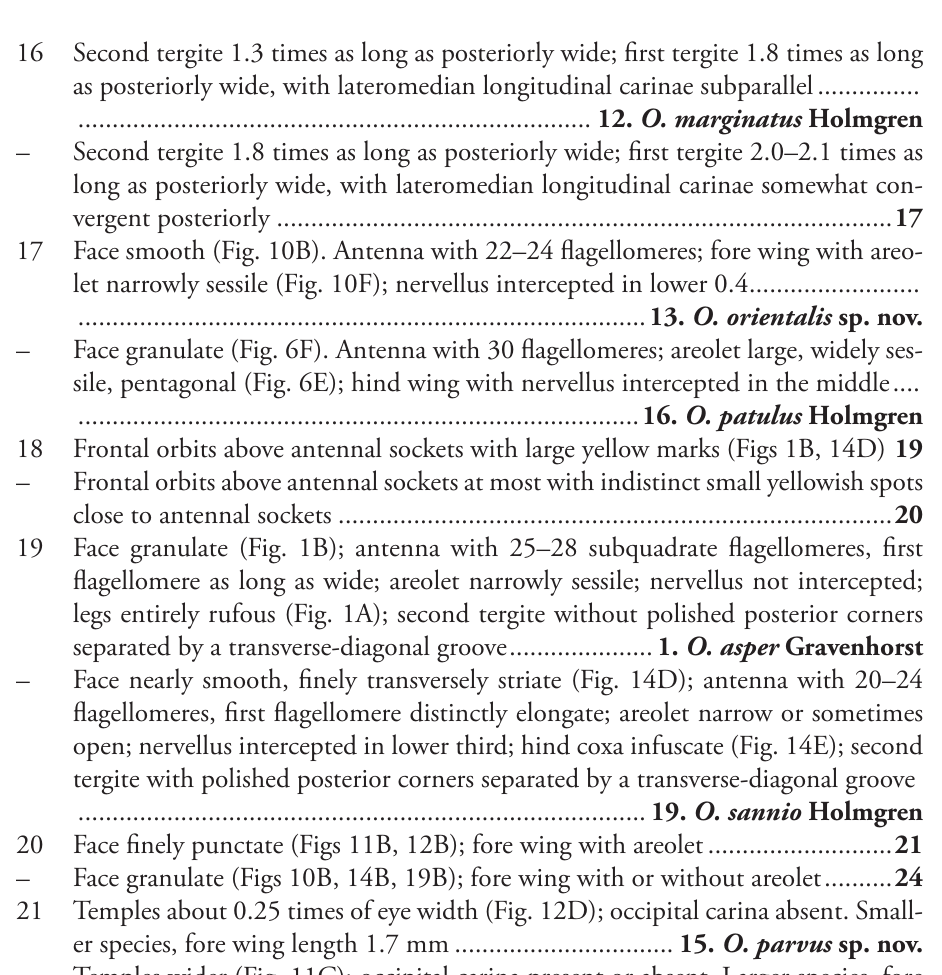
Second tergite 1.3 times as long as posteriorly wide; first tergite 1.8 times as long as posteriorly wide, with lateromedian longitudinal carinae subparallel ............... – Second tergite 1.8 times as long as posteriorly wide; first tergite 2.0–2.1 times as long as posteriorly wide, with lateromedian longitudinal carinae somewhat con- 17 Face smooth (Fig. 10B). Antenna with 22–24 flagellomeres; fore wing with areo- let narrowly sessile (Fig. 10F); nervellus intercepted in lower 0.4 ......................... – Face granulate (Fig. 6F). Antenna with 30 flagellomeres; areolet large, widely ses- sile, pentagonal (Fig. 6E); hind wing with nervellus intercepted in the middle .... 18 Frontal orbits above antennal sockets with large yellow marks (Figs 1B, 14D) 19 – Frontal orbits above antennal sockets at most with indistinct small yellowish spots close to antennal sockets ................................................................................. 20 19 Face granulate (Fig. 1B); antenna with 25–28 subquadrate flagellomeres, first flagellomere as long as wide; areolet narrowly sessile; nervellus not intercepted; legs entirely rufous (Fig. 1A); second tergite without polished posterior corners separated by a transverse-diagonal groove ..................... 1. O. asper Gravenhorst – Face nearly smooth, finely transversely striate (Fig. 14D); antenna with 20–24 flagellomeres, first flagellomere distinctly elongate; areolet narrow or sometimes open; nervellus intercepted in lower third; hind coxa infuscate (Fig. 14E); second tergite with polished posterior corners separated by a transverse-diagonal groove 20 Face finely punctate (Figs 11B, 12B); fore wing with areolet ........................... 21 – Face granulate (Figs 10B, 14B, 19B); fore wing with or without areolet .......... 24 21 Temples about 0.25 times of eye width (Fig. 12D); occipital carina absent. Small- er species, fore wing length 1.7 mm ................................ 15. O. parvus sp. nov. – Temples wider (Fig. 11C); occipital carina present or absent. Larger species, fore wing length at least 2.2 mm ............................................................................ 22 22 Hind legs partly fuscous, hind coxa brown to black (Fig. 14E). Head almost cubic, subocular sulcus not developed; occipital carina absent; notauli not devel- oped. Face fuscous (Fig. 14F) .................................. 21. O. spurius Gravenhorst – All legs entirely red; subocular sulcus distinct; occipital carina present, often re- duced dorsally; mesoscutum anteriorly with distinct notauli (Fig. 11A, E). Face yellowish or infuscate ...................................................................................... 23 23 Antenna with 25–29 flagellomeres; second tergite as long as posteriorly wide or transverse, polished with distinct longitudinal striae; vein Rs+2r meeting pter- ostigma at proximal 0.4 (Fig. 1E). Larger species, fore wing 3.4–4.0 mm ............ – Antenna with 24–25 flagellomeres; second tergite 1.2 times as long as posteriorly wide, coriaceous, without striae (Fig. 11G); vein Rs+2r meeting middle of pterostig- ma (Fig. 11F). Smaller species, fore wing 2.2–2.5 mm ........ 14. O. pacificus sp.